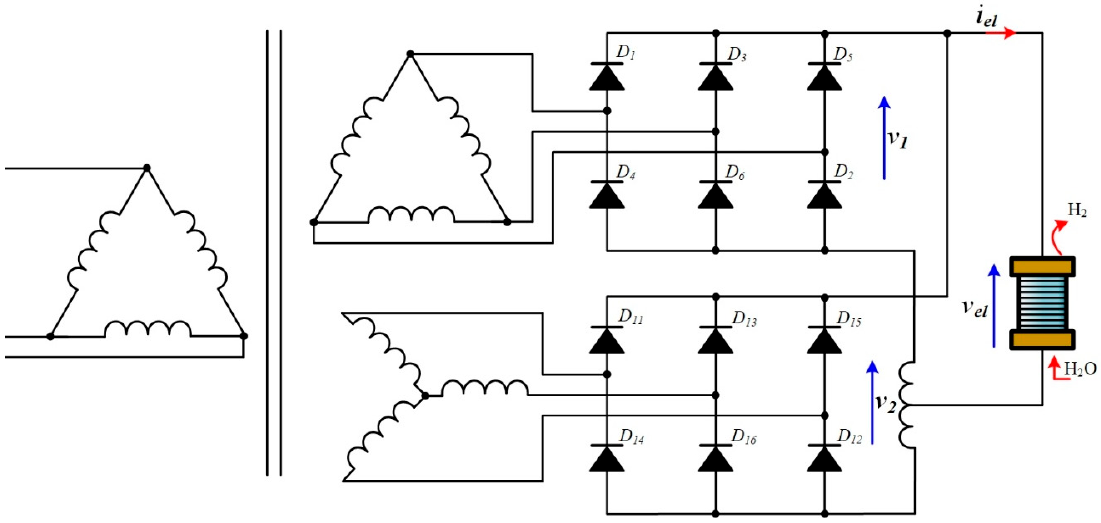
Figure 5. 12-pulse diode bridge rectifier.